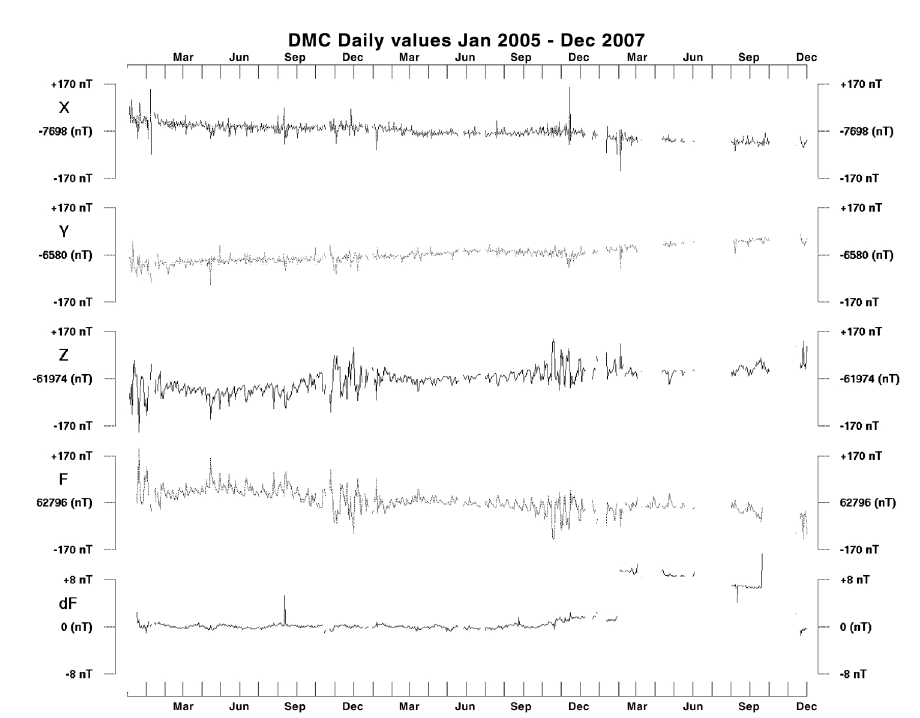
Fig. 10. Daily mean values of the absolute field. X, Y, Z are the components in the geographical reference frame. F and dF are equivalent to Fv and dF, respectively, on fig.